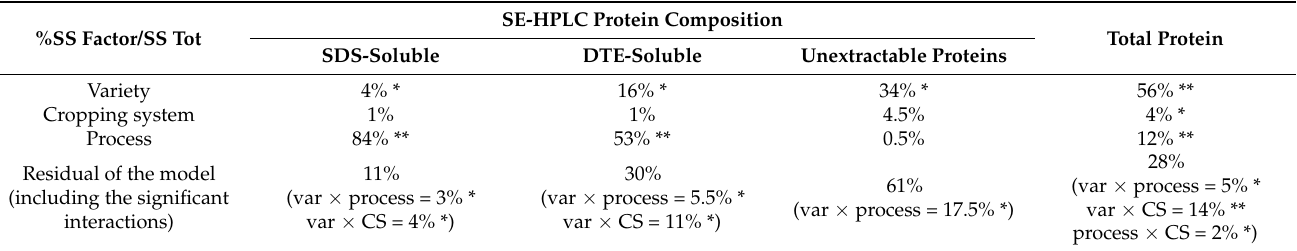
Table 11. Contribution of each factor to the variability of the parameters: percentage of proteins soluble in the SDS, proteins soluble in the DTE, unextractable proteins, and total protein content.